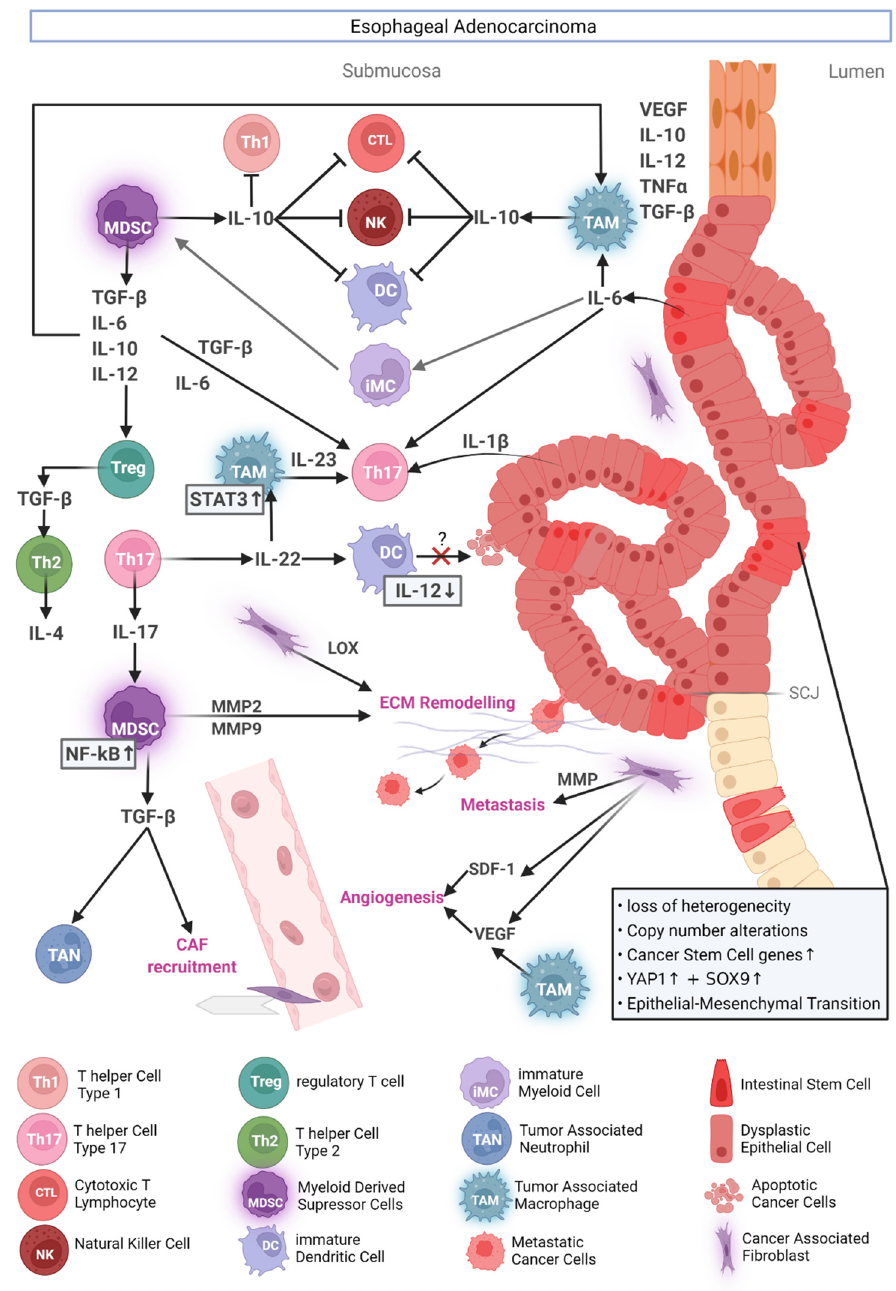
Figure 2. Tumor Microenvironment in Esophageal Adenocarcinoma. Redundant processes suppress central events in anti-tumor immunity, such as CTL and NK cell activity and associated Th1 activation, or DC maturation. Abbreviations: CAF = Cancer Associated Fibroblast; ECM = Extracellular Matrix; IL = Interleukin; LOX = Lysyl Oxidase; PPI = Proton Pump Inhibitor; SCJ = Squamo-Columnar Junction; SDF-1 = Stromal Cell Derived Factor 1; TGF- β = Transforming Growth Factor β ; SOX9 = SRY-Box Transcription Factor 9; TNF α = Tumor Necrosis Factor α ; VEGF = Vascular Endothelial Growth Factor; MMP = Matrix Metalloproteinase; and YAP1 = yes-associated protein 1. Generated with biorender.com.